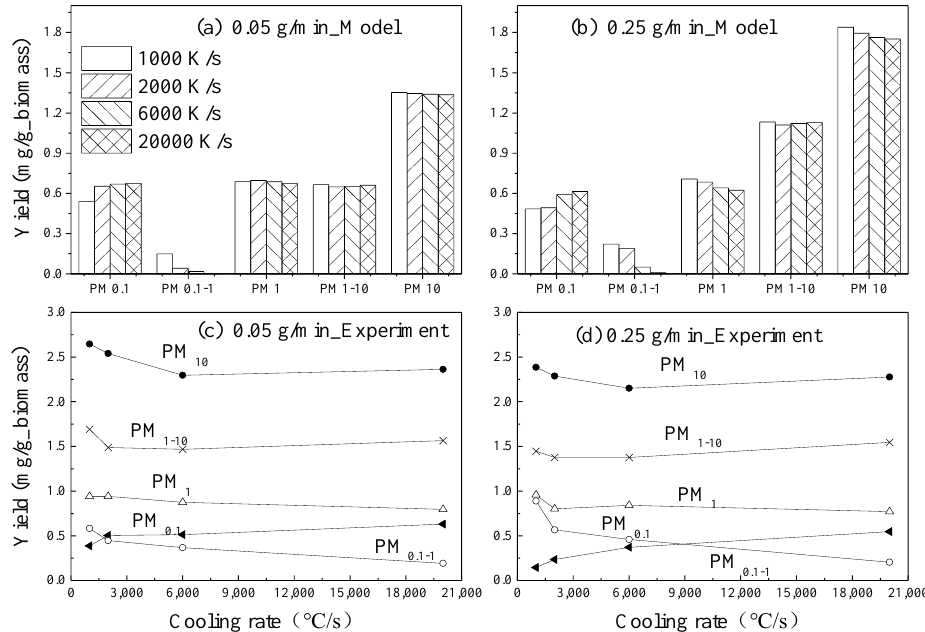
Figure 7. The comparison of the calculated yields of PM 10 with experimental measurements varies with different cooling rates at two biomass feeding rates. ( a , b ) are the calculated yields of PM at the biomass feeding rate of 0.05 g/min and 0.25 g/min, respectively; ( c , d ) are the measured yields of PM at the biomass feeding rate of 0.05 g/min and 0.25 g/min.